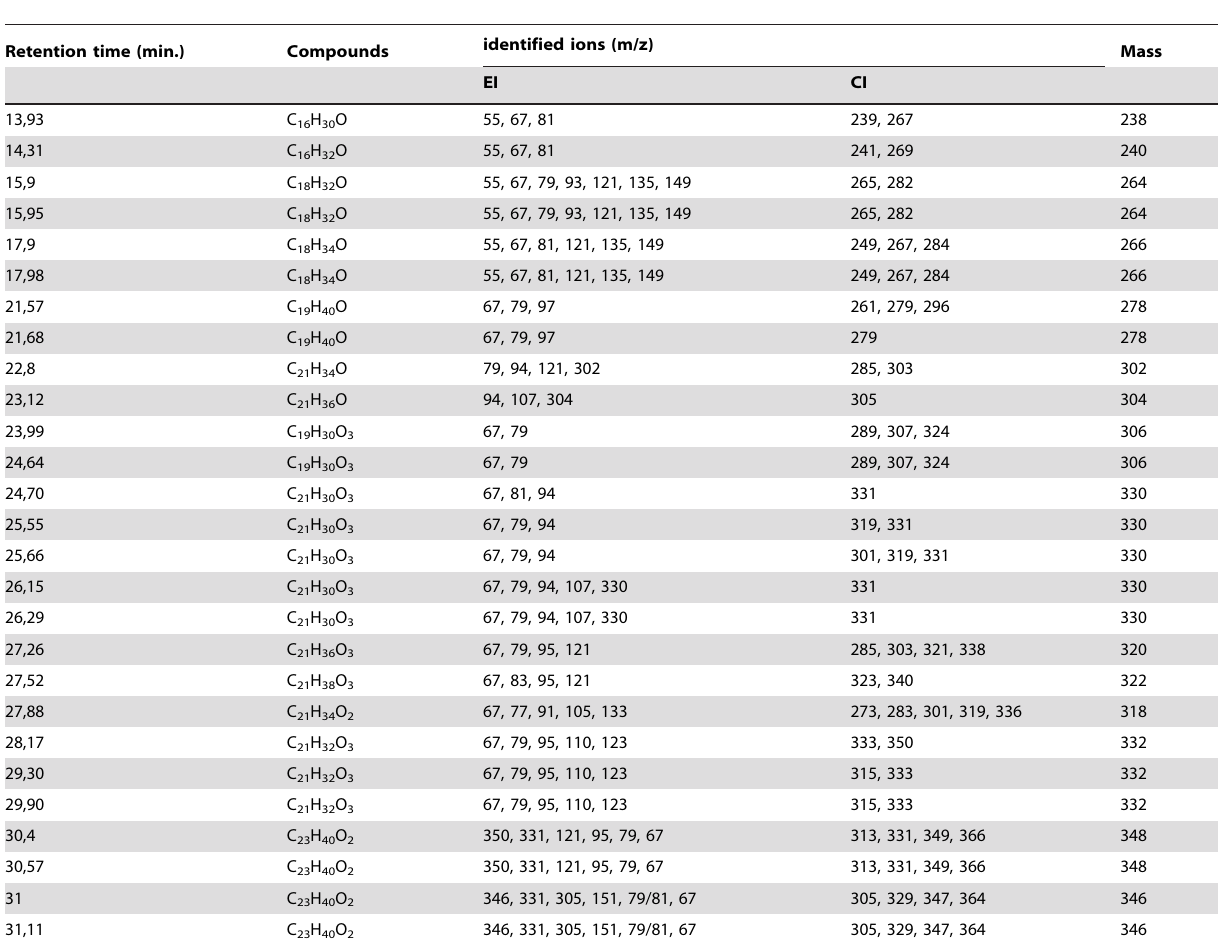
Table 2. Mass of the peaks from Fig. 2 and the corresponding identification according to Daloze et al. 1987, 1991 [33,34].